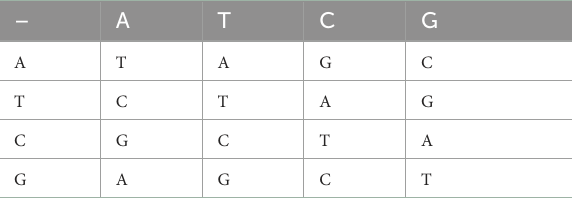
Here X and Y are the state variables and K is the